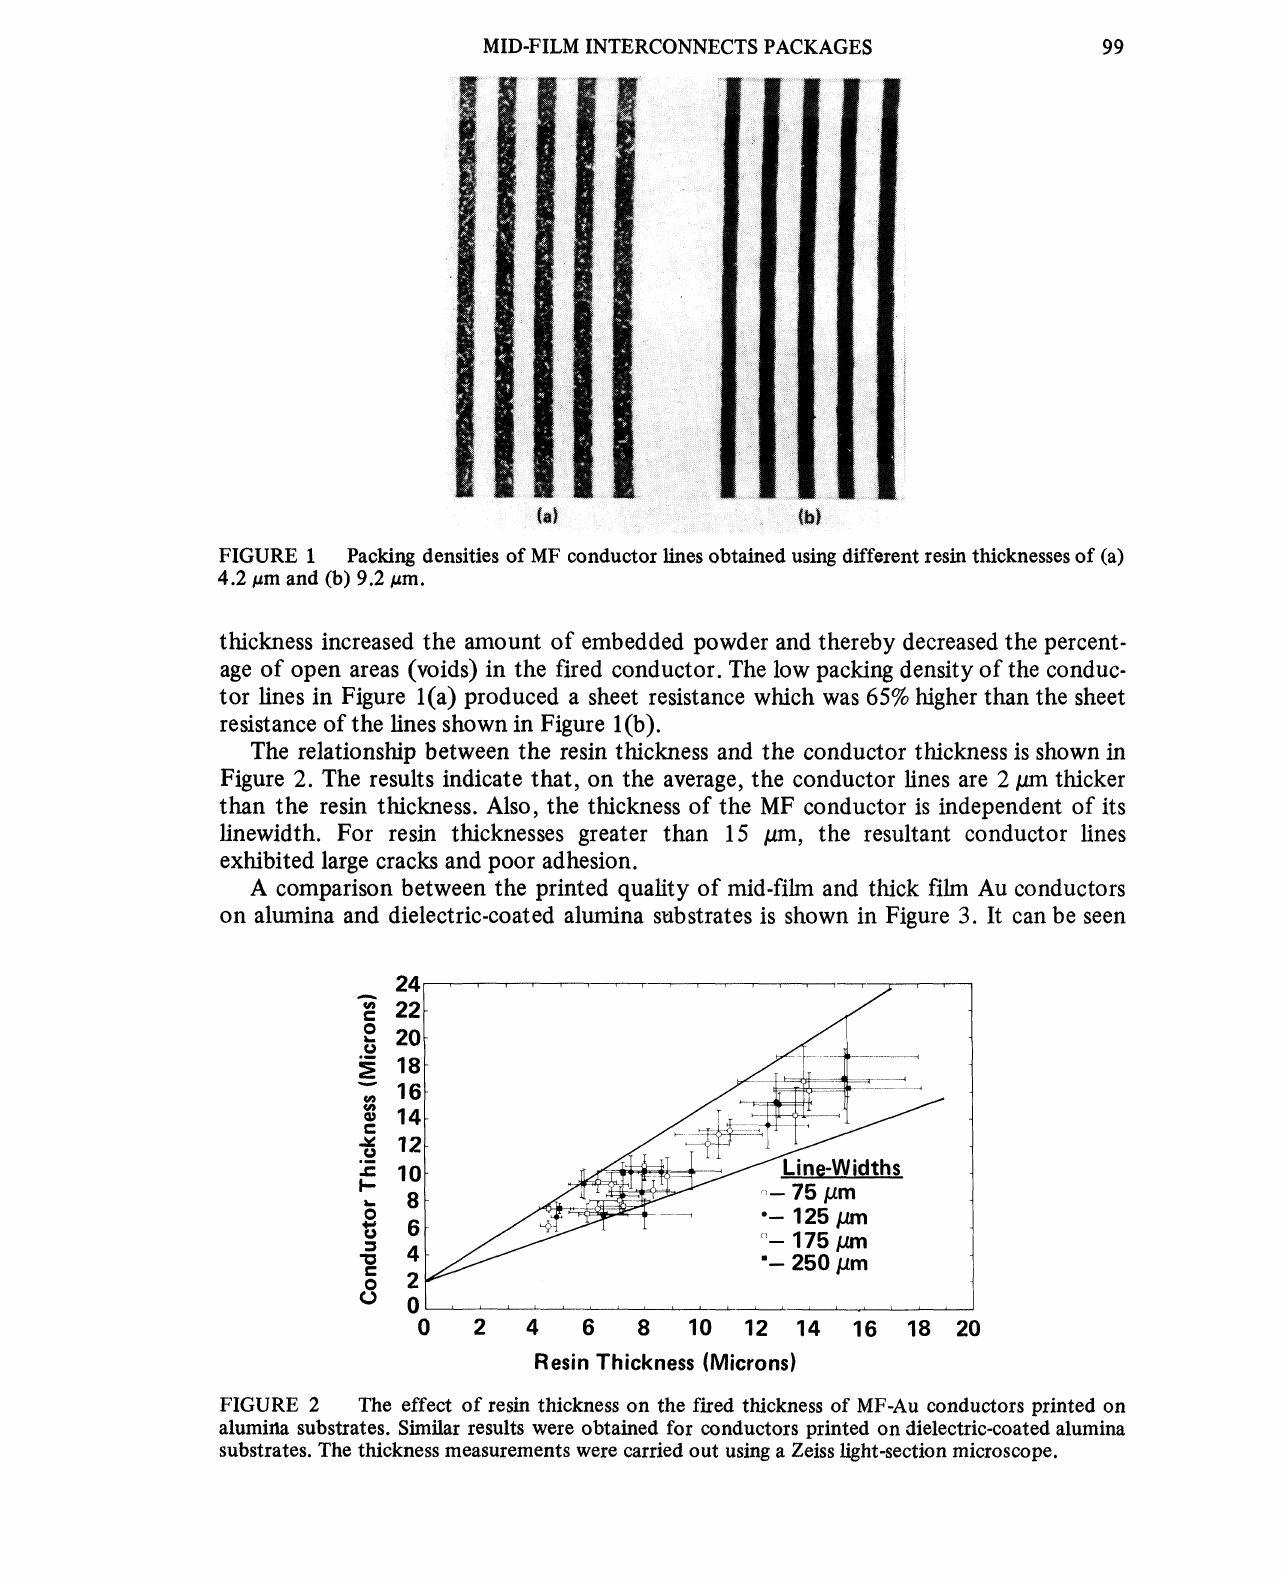
The effect of resin thickness on the fired thickness of MF-Au conductors printed on alumirla substrates. Similar results were obtained for conductors printed on dielectric-coated alumina substrates. The thickness measurements were carried out using a Zeiss light-section